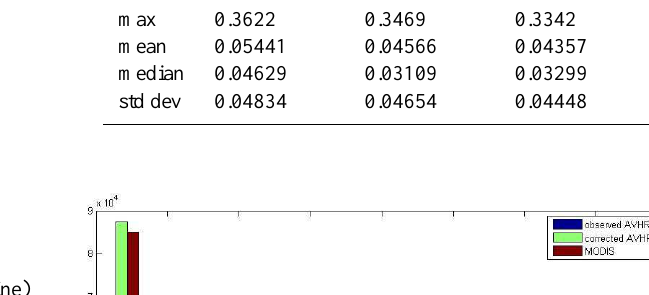
Fig. 6. EOF loadings for modes 1 and 3 in rotated case (black line) Fig. 6: EOF loadings for modes 1 and 3 in rotated case (black line) and corresponding and corresponding synthetic loadings (in red line) computed by lin- synthetic loadings (in red line) computed by linearly regressing the loadings with the time early regressing the loadings with the time of observation. of observation.